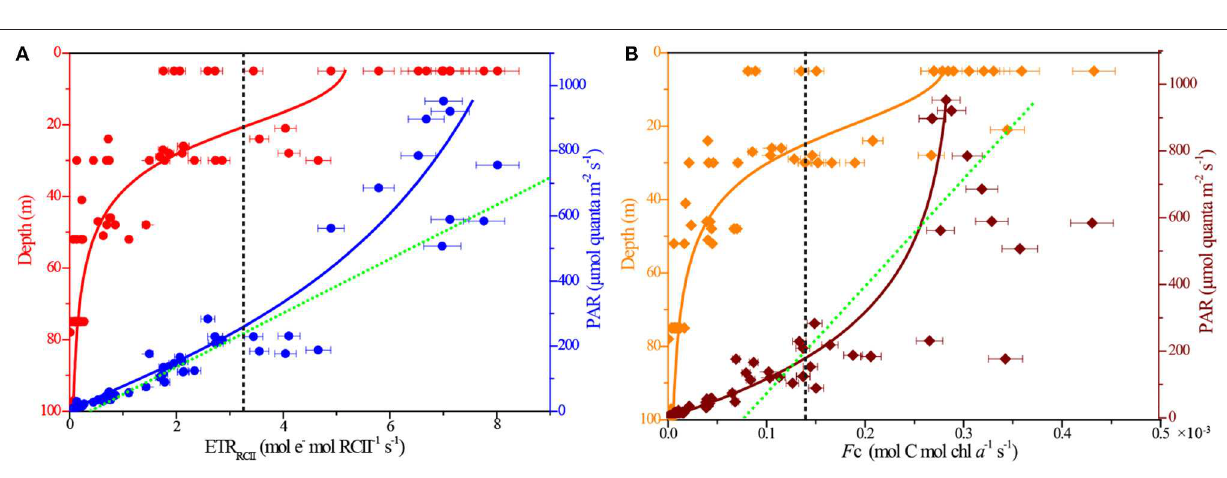
( Figure 6a ). The FRRF- GP z,t integrated over Z eu depth ( GP Zeu )